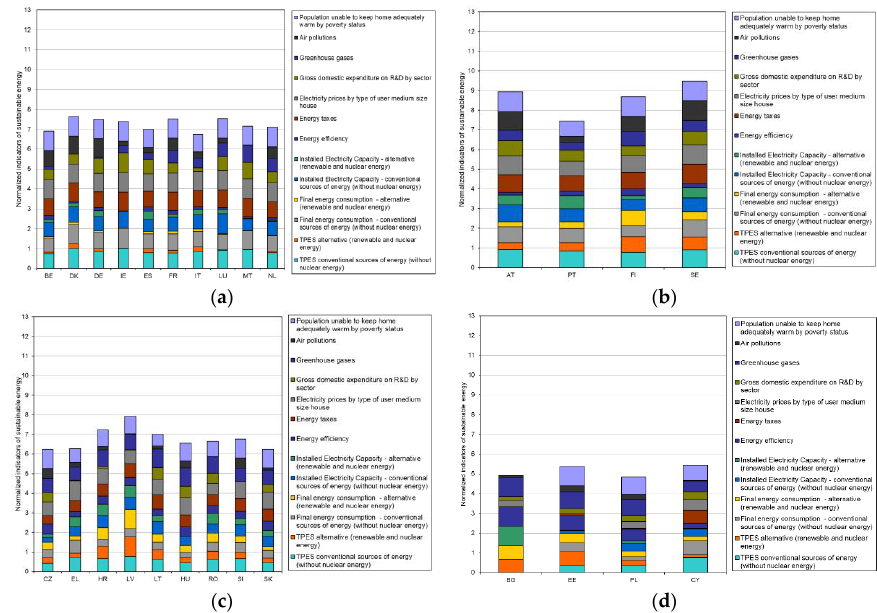
Figure 8. Profiles of sustainable energy development versus the GDP value of individual countries for similar groups (( a )-cluster 1, ( b )-cluster 2, ( c )-cluster 3, ( d )-cluster 4).